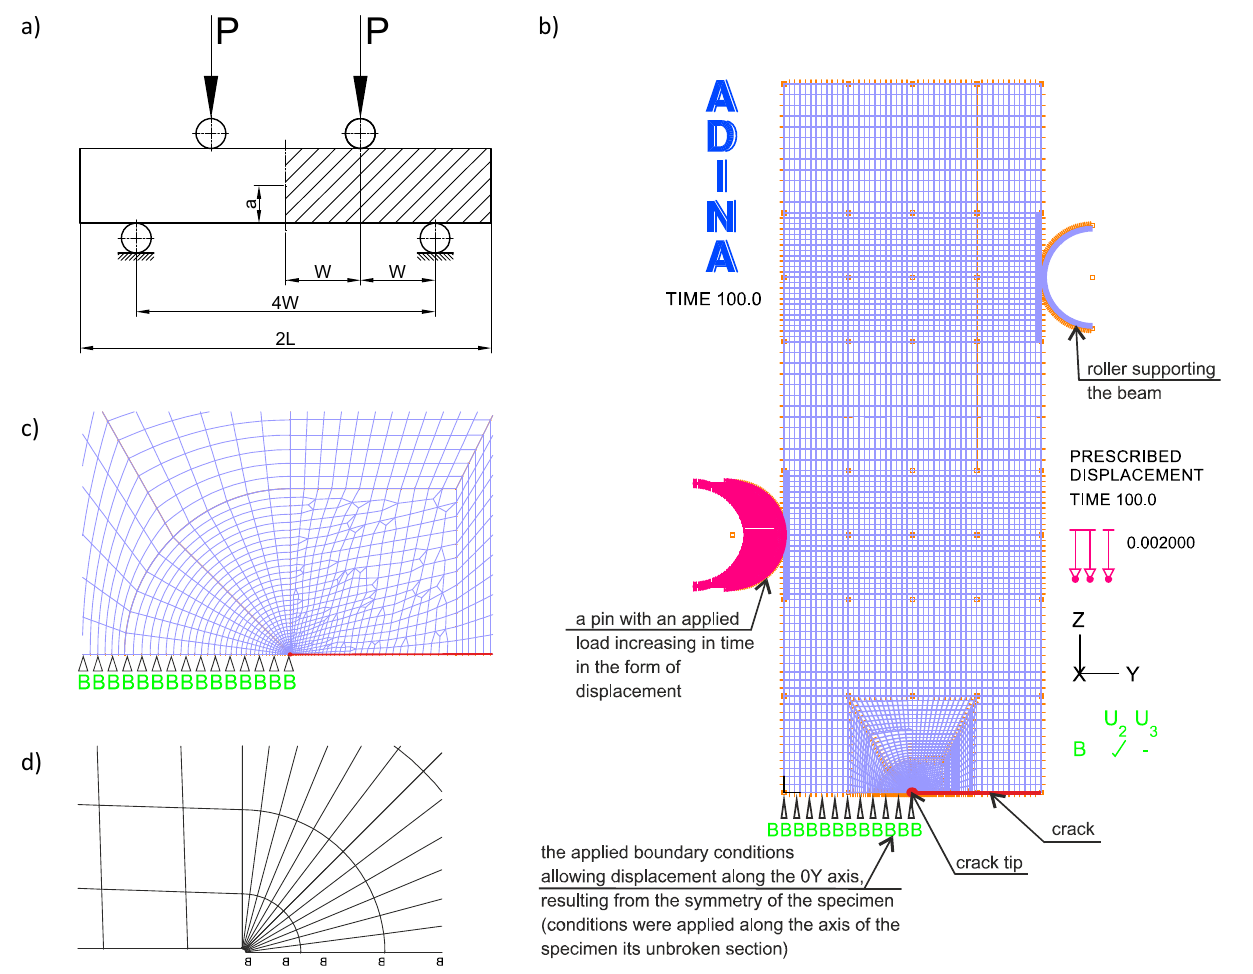
Figure 2: Numerical model of the SEN ( 4PB ) specimen: ( a ) simpli fi ed technical drawing of the beam with a hatched fragment, which was modeled; ( b ) full numerical model; ( c ) the apical area; and ( d ) the shape of the crack tip [ 15 ]